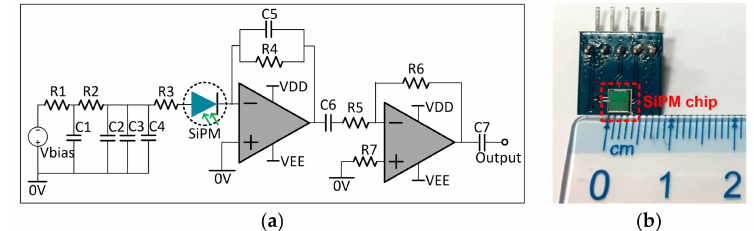
Figure 2. Silicon photomultiplier (SiPM)-based partial-discharge (PD) detector. ( a ) Simplified read-out circuit; ( b ) SiPM sensor used in the test. C1 = C2 = C3 = C4 = 10 nF; C5 = 100 pF; C6 = C7 = 0.1 µ F; R1 = R2 = R5 = 50 Ω ; R3 = R7 = 1 k Ω ; R4 = 100 Ω ; R6= 0.3 k Ω . The SiPM sensor in the circuit is the